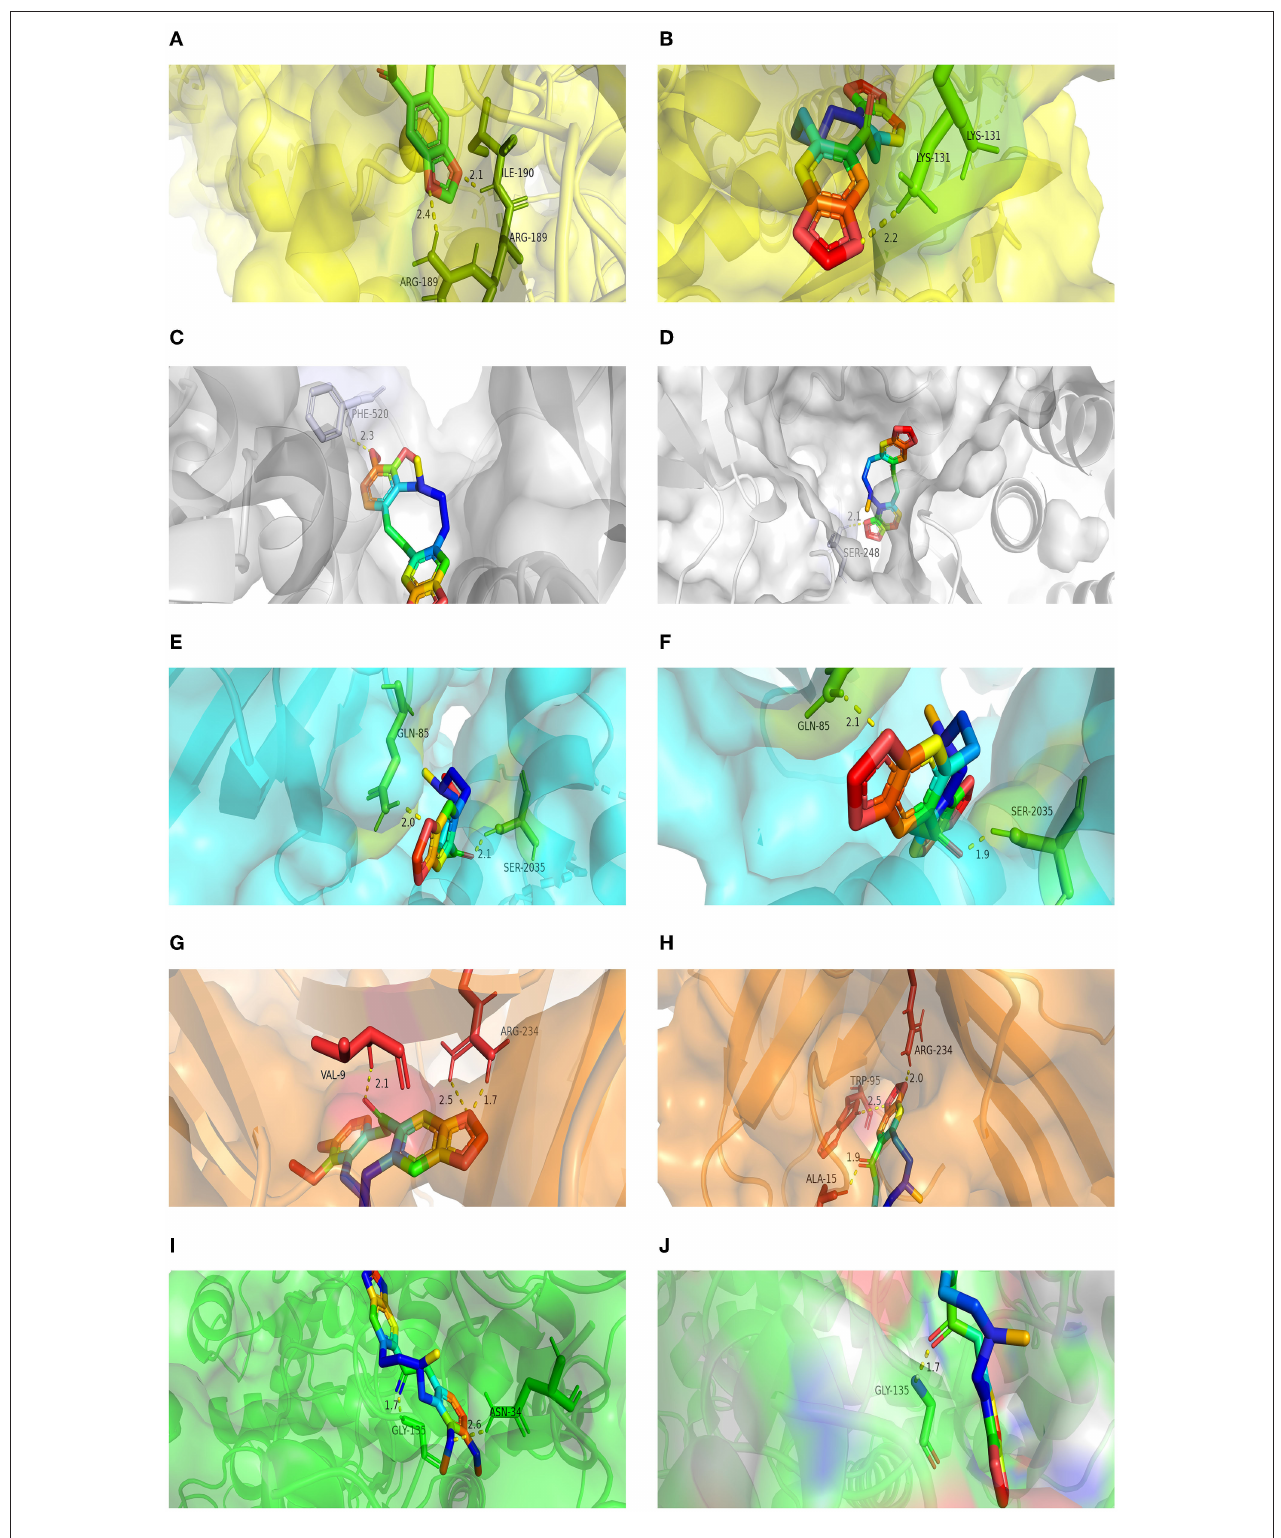
FIGURE 7 | Molecular docking results for MPTA. (A) Docking mode for ALL-MAPK3; (B) docking mode for PRO-MAPK3; (C) docking mode for ALL-SRC; (D) docking mode for PRO-SRC; (E) docking mode for ALL-MTOR; (F) docking mode for PRO-MTOR; (G) docking mode for ALL-PIK3CA; (H) docking mode for PRO-PIK3CA; (I) docking mode for ALL-PTGS2; and (J) docking mode for PRO-PTGS2.